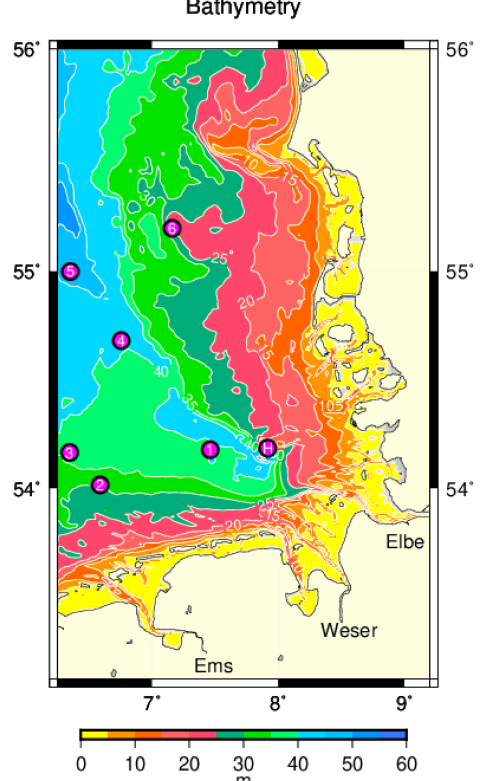
Figure 1. German Bight bathymetry. The magenta circles indicate the locations of six stations of the MARNET monitoring network (1–6) and of the island of Heligoland